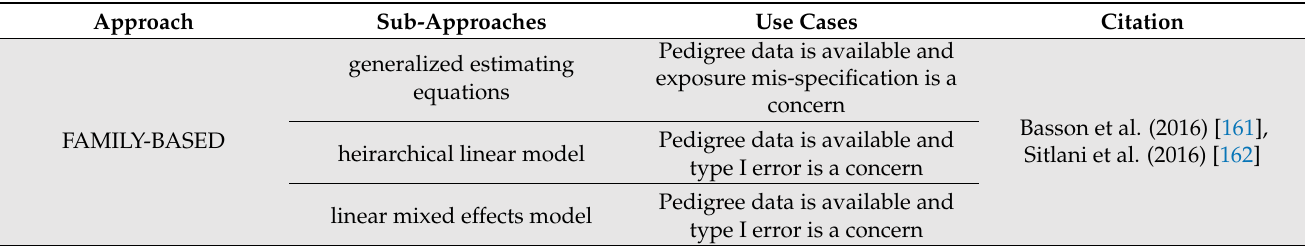
Table 1. Comparison between methods that are described in the text that can be used to identify GxE. Sub-approaches are presented with over-arching approach that they draw from. Methods are presented with use case situations where they are generally considered